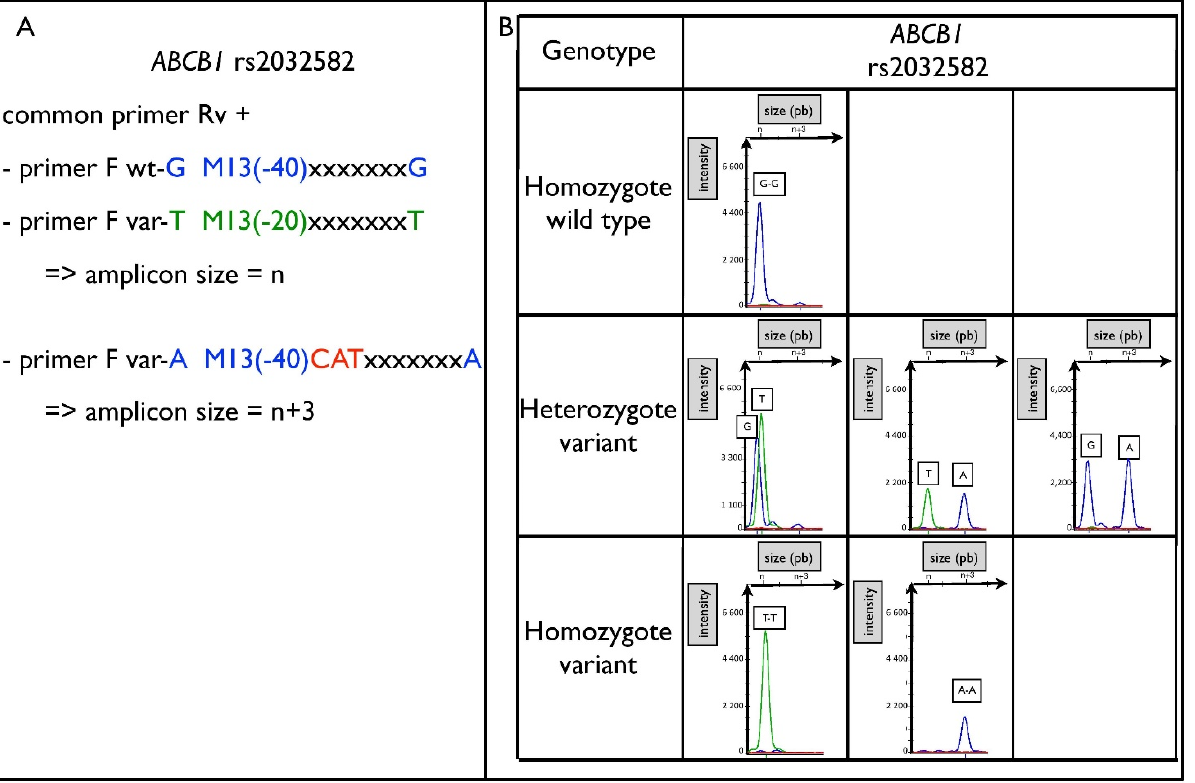
Figure 3. Resolution of tri-allelic SNP. Primer design for ABCB1 rs2032582 ( A ). Representative electrophoregram results of the migration of fragments according to genotype ( B ). ABCB1 rs2032582 illustrates results of tri-allelic discrimination for a single-nucleotide polymorphism. The green peak corresponds to the fluorescence of the HEX probe and the blue peak corresponds to the fluorescence of the FAM probe.